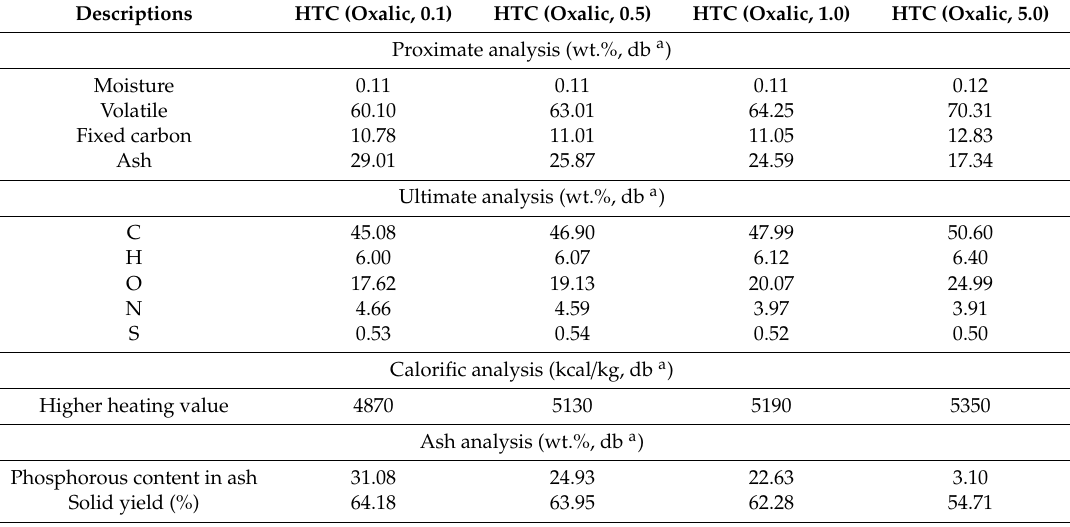
Table 2. Characteristic properties of HTC products including di ff erent weight fractions of oxalic acid.